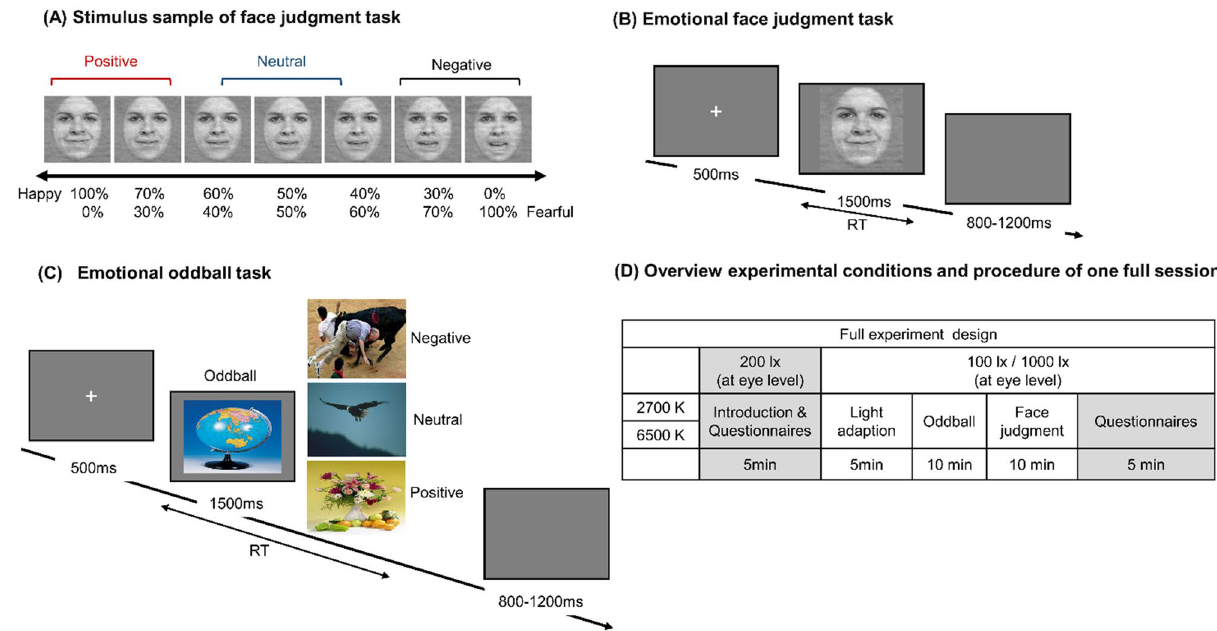
Figure 2. ( A ) Stimulus sample of face judgment task: female, facial expression ranges from 100% happy /0% fearful to 0% happy /100% fearful, all morphs were created by customized scripts in MATLAB R2017a (MathWorks Inc., Natick, MA, USA). ( B ) Emotional face judgment task. A face was presented after a fixation cross, and then participants were required to judge whether the emotion conveyed by the face is "fearful" or "happy" within 1.5 s. ( C ) Emotional oddball task. A picture was presented after a fixation cross, and participants were required to answer whether it is a standard stimulus or an oddball stimulus within 1.5 s immediately. ( D ) Overview of experimental condition and schematic representation of one full session. Note that the task order was the same on two experiment days and counterbalanced between the